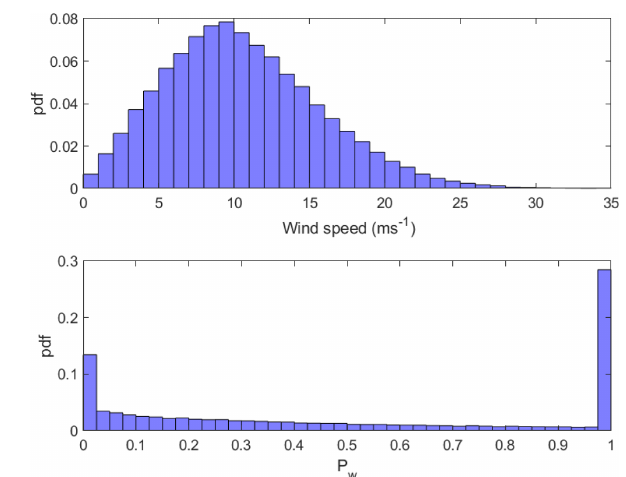
Figure 2. Example distribution for Ekofisk (ek) showing the prob- ability density function (pdf) for both wind speed (ms − 1 ) and nor- malized wind power ( P w